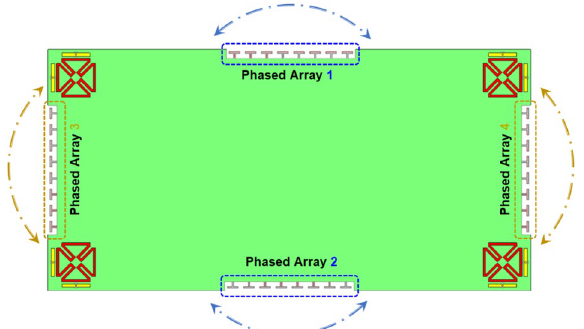
Figure 28. Different placements of the introduced MM-Wave array into the smartphone mainboard.